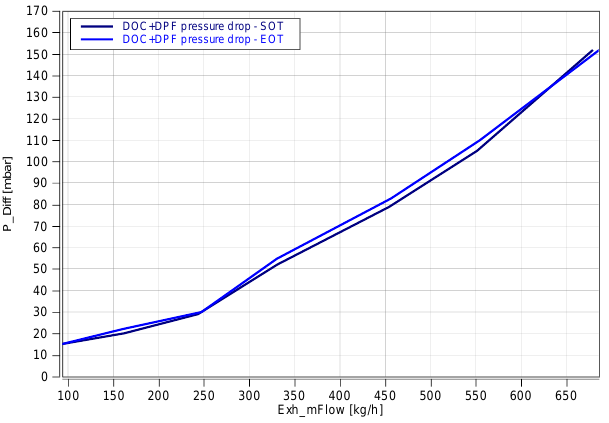
Fig. 10. DOC-DPF pressure drop test results